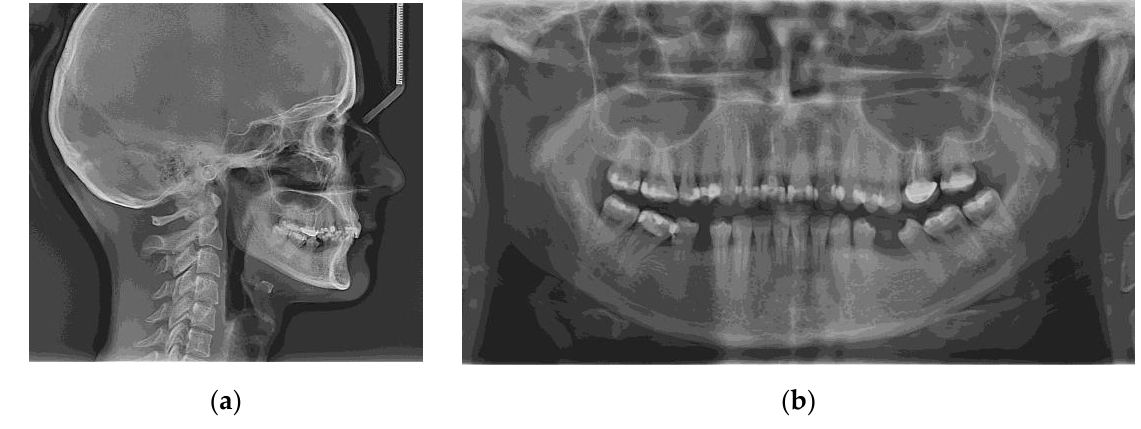
Figure 3. Radiographic examination before treatment: ( a ) Initial lateral cephalogram; ( b ) Initial panoramic radiograph.